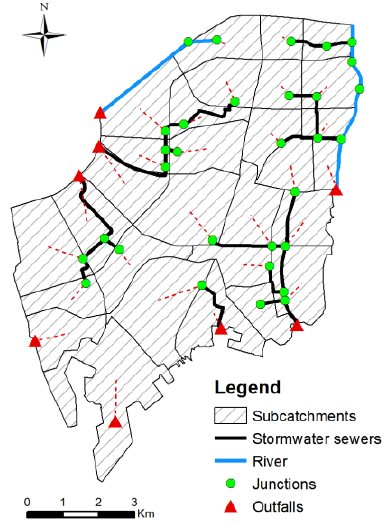
Figure 3. The divided subcatchments of the Storm Water Management Model (SWMM).